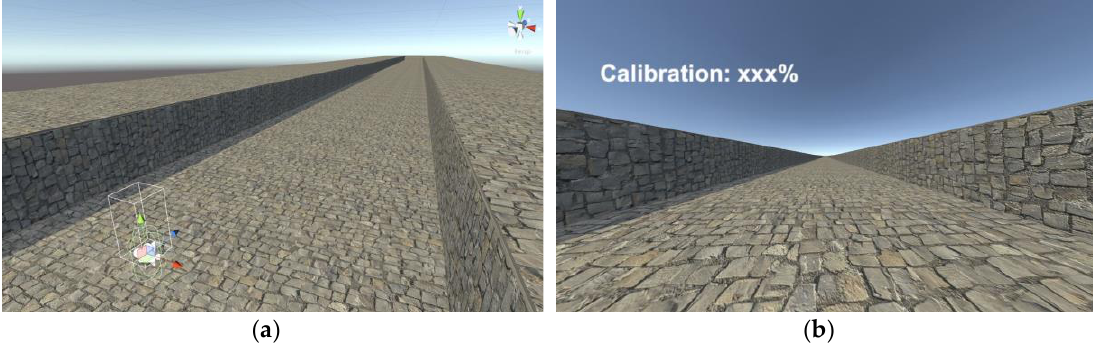
Figure 13. A 20 × 400 m 2 virtual space surrounded by walls: ( a ) a map with a bird’s-eye view, and ( b ) a scene and a user interface (UI) viewed through the display of the HMD.